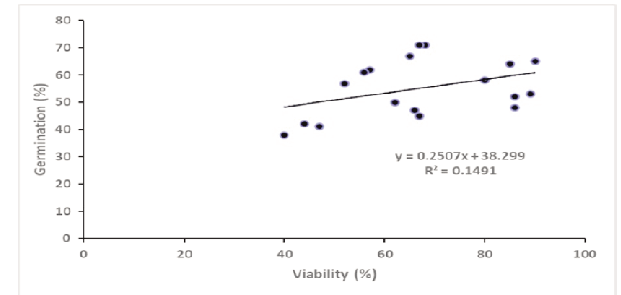
Fig. 1 - Correlation between viability and in vitro germination of fresh pollen in six pistachio cultivars grown in Maru Agricultural Research Station. Significant regression at P <0.05.